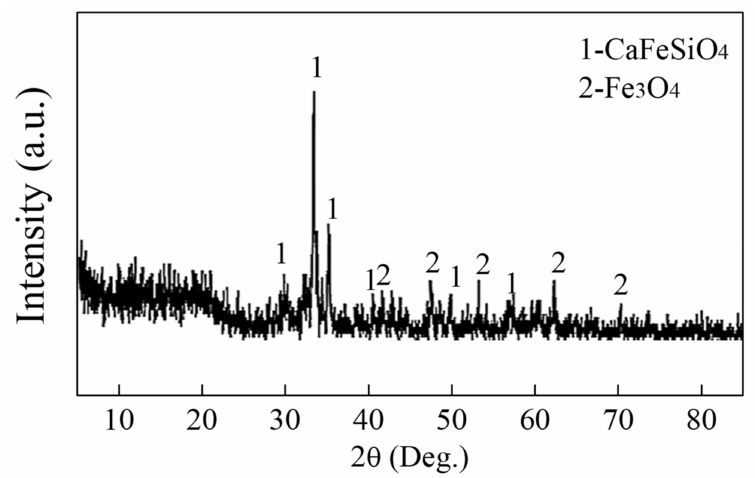
Figure 10. XRD pattern of dephosphorization slag in Heat 4.